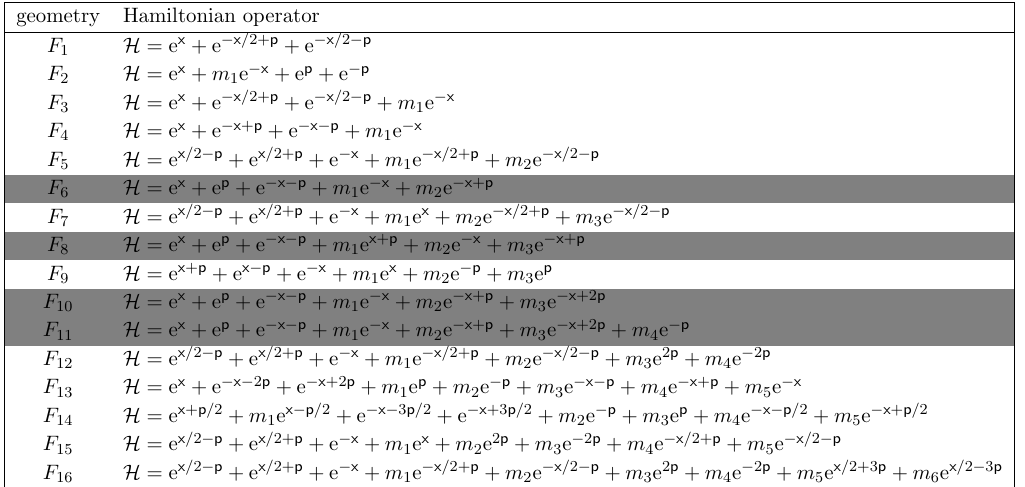
Figure 1 . Sixteen re(cid:13)exive Newton polygons.